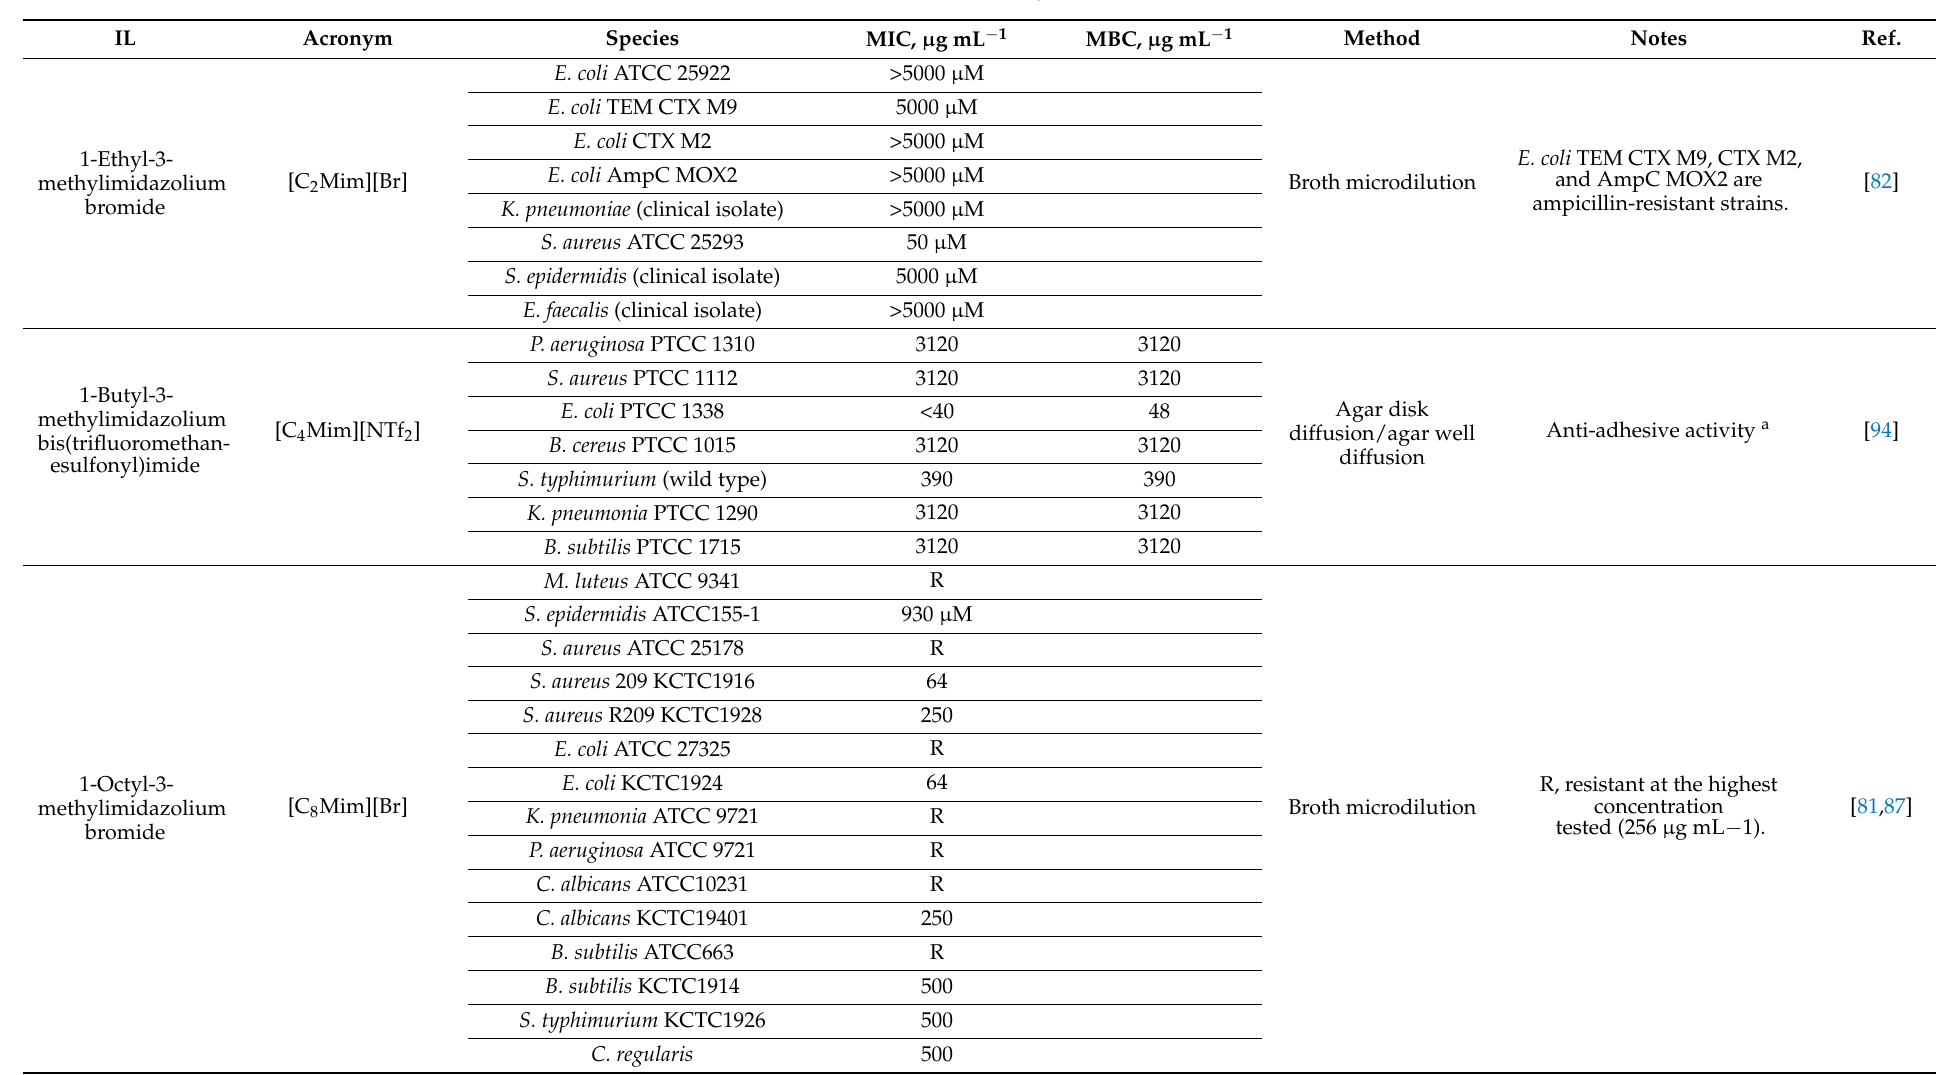
Table 2. Antimicrobial activity of common ILs